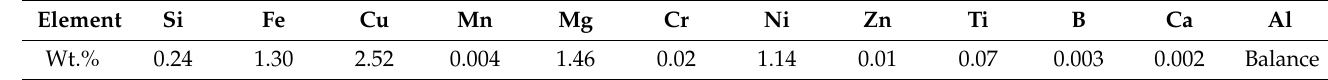
Table 1. Constituents of Al2618 [11].